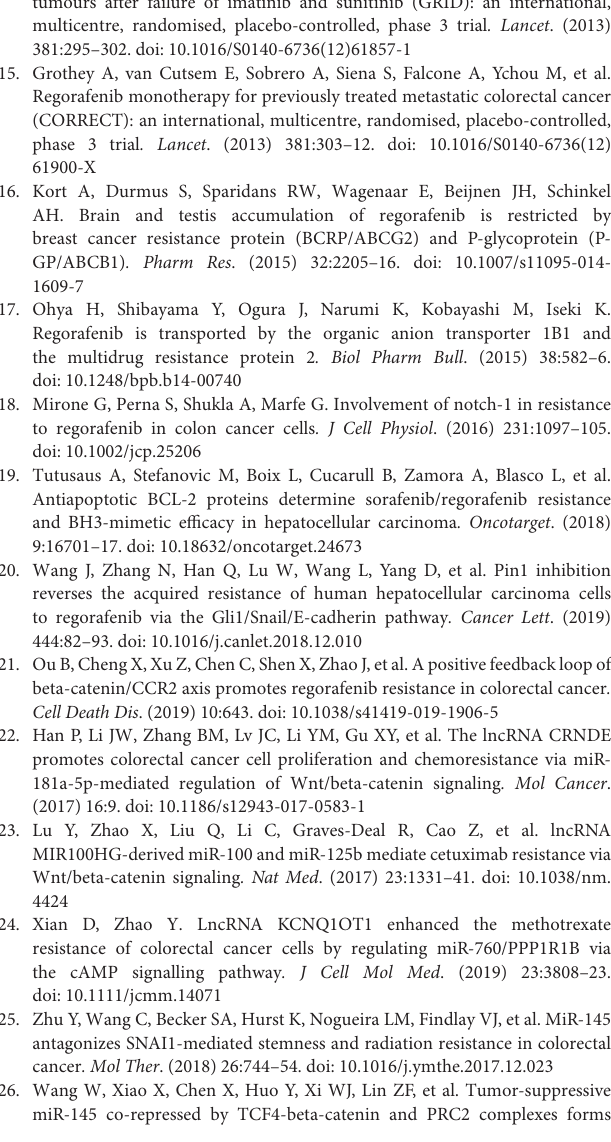
Figure S1 | The IC 50 values for three subclones of SW480 and